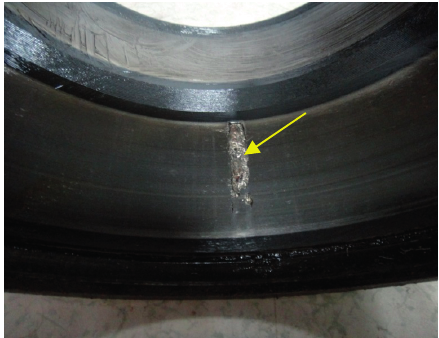
Figure 20. Outer-race of the dismantled